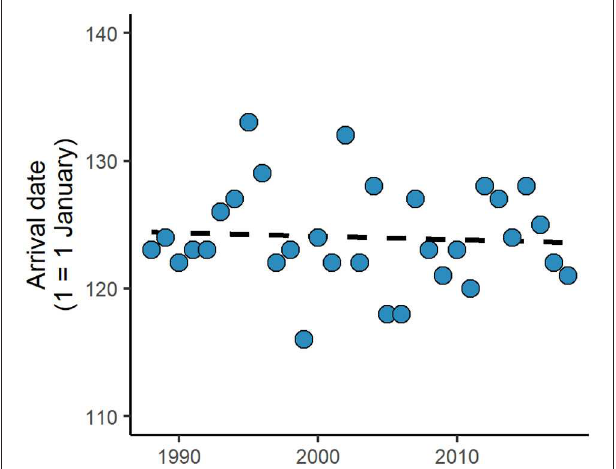
FIGURE 1 | Arrival dates of whimbrels into South Iceland in the 31-year period from 1988 to 2018, updated from Gunnarsson and Tómasson (2011), showing no significant trend (day of the year = − 0.027 * year + 178.11, n = 31, R 2 = 0.004, p =